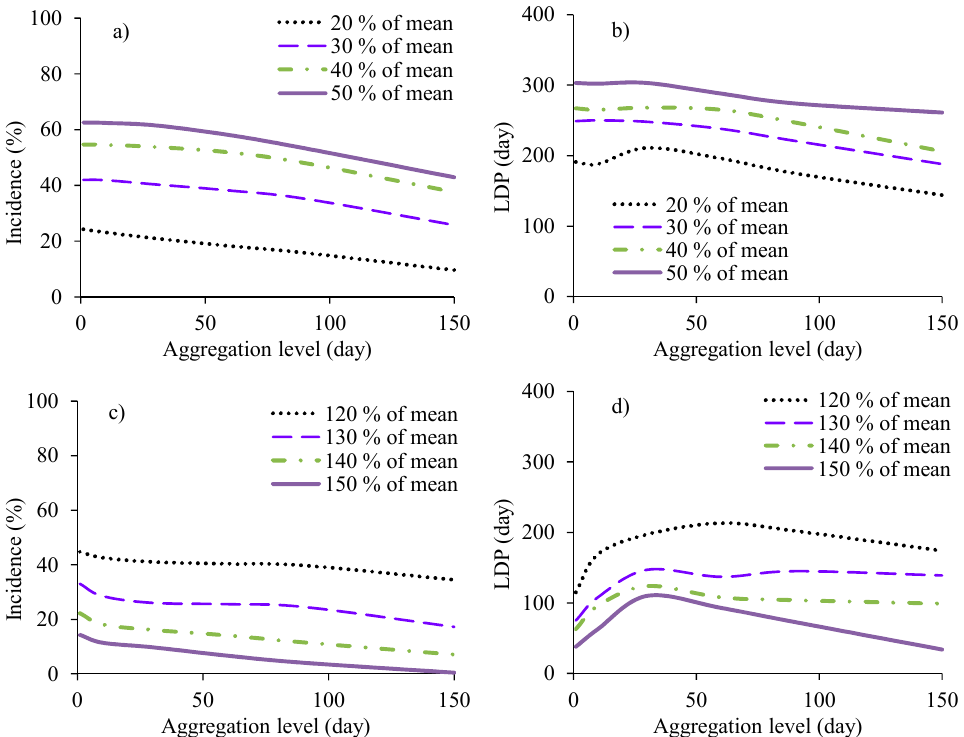
Figure A7. IDT relationships for: ( a ) hydrological drought; and ( c ) meteorological drought. LDP-DT relationships for: ( b ) hydrological drought; and ( d ) meteorological drought.